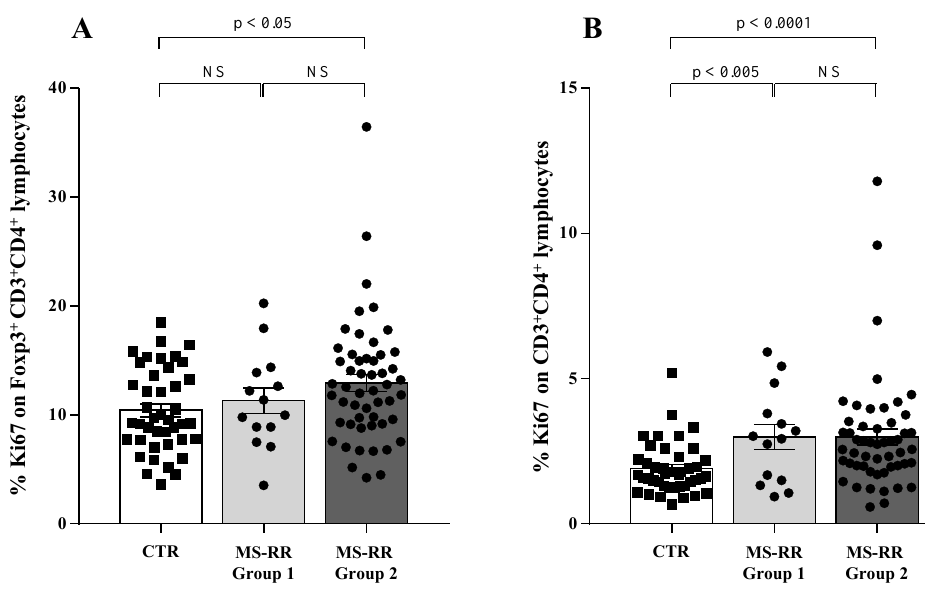
Figure 7. Higher intracellular SOD-1 content in T cells in MS-RR Group 2 subjects was associated with increased proliferation ability of Treg. White column with black squares shows the healthy controls; light grey column with black dots represents the MS-RR Group 1; dark grey column with black dots indicates the MS-RR Group 2 individuals. ( A ) ki67 expression, largely associated with cell proliferation, in the Treg subset. ( B ) ki67 expression in CD4 + T lymphocytes (T conv ). Statistical evaluation of data was performed by means of the Mann–Whitney test.